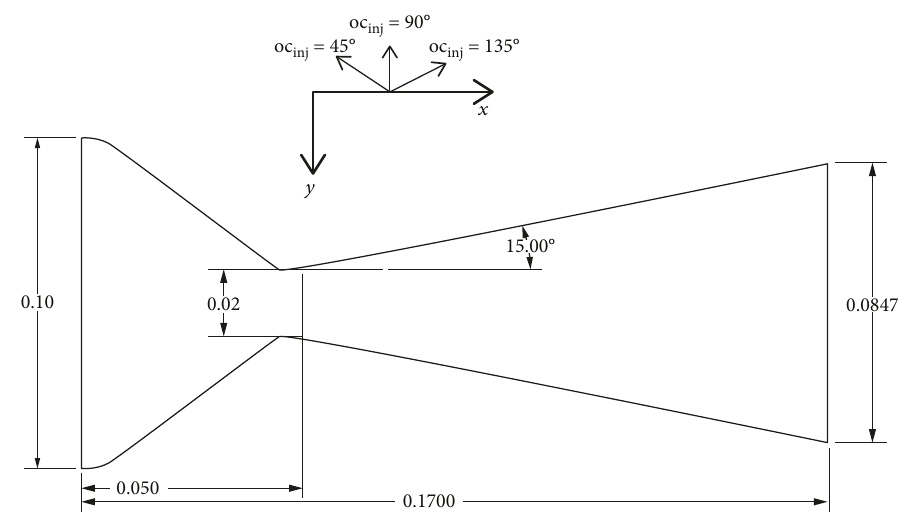
Figure 7: Geometric model of 2D convergent divergent nozzle (units in m). Table 2: Computational grids for the grid independence